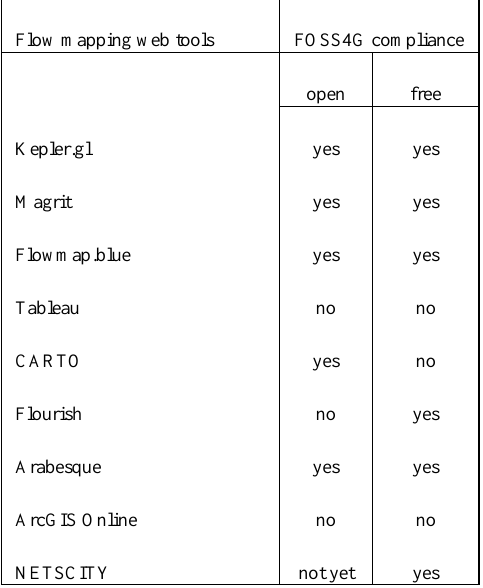
Table 1 . Software licensing of a selection of online flow mapping